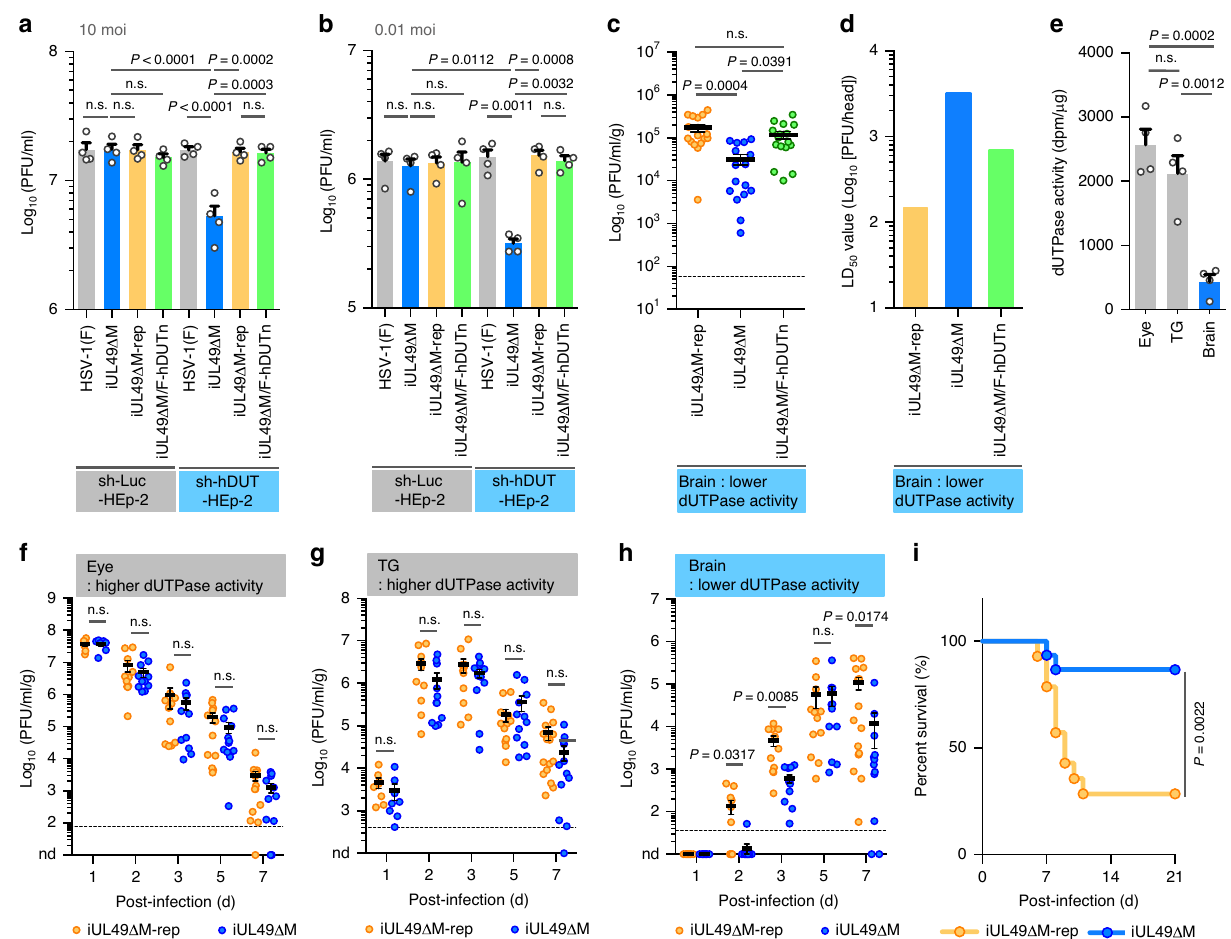
Fig. 5 piUL49 is required to compensates for low cellular dUTPase activity. a , b Viral titers of sh-Luc-HEp-2 or sh-hDUT-HEp-2 were infected with wild- type HSV-1(F), iUL49 Δ M, iUL49 Δ M-rep or iUL49 Δ M/F-hDUTn for 36 h at an MOI of 10 ( a ) or for 60 h at an MOI of 0.01 ( b ), respectively, and